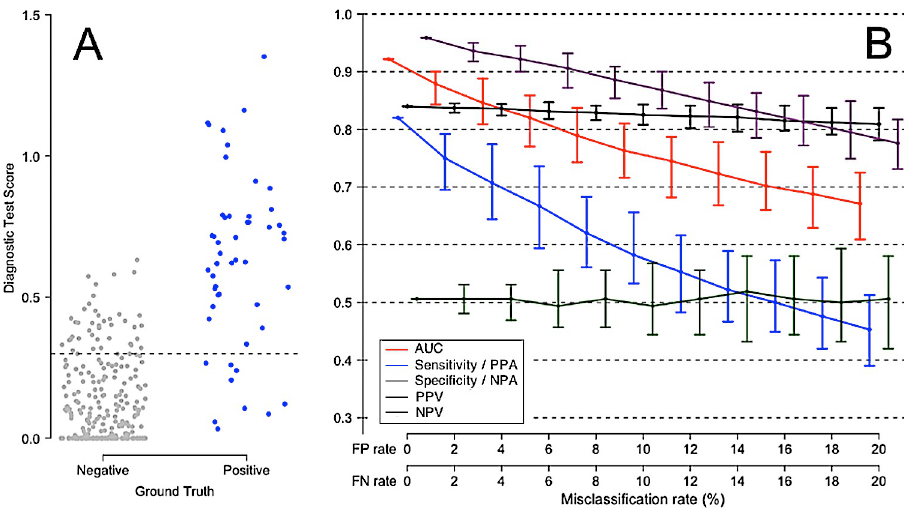
Fig 5. A simulated inaccurate screening test in a moderately low prevalence setting. In this scenario, ground truth positive patients are equally likely to be misclassified as ground truth negative patients. (A) Representation of Ground Truth for 250 negative patients, and 50 positive patients, with significant overlap between the positive and negative ground truth distributions. (B) Apparent performance of diagnostic test, as a function of the misclassification rate of the comparator. The error bars describe 95% empirical confidence intervals about medians, computed over 100 simulation cycles. True test performance is indicated when the FP and FN rates are each 0%. The terms Sensitivity and Specificity are appropriate when there is no misclassification in the comparator (FP rate = FN rate = 0%). The terms Positive Percent Agreement (PPA) and Negative Percent Agreement (NPA) should be used in place of Sensitivity and Specificity, respectively, when the comparator is known to contain